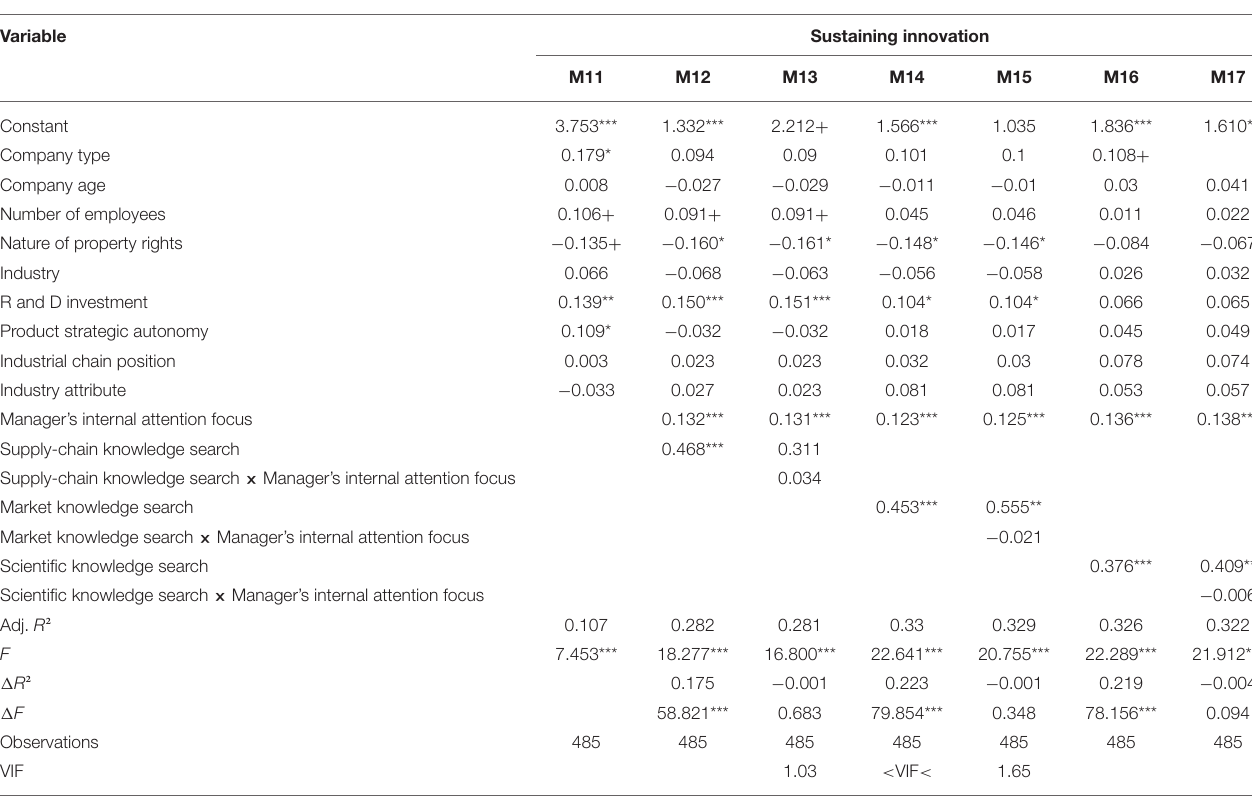
TABLE 7 | Moderating effect of manager’s internal attention